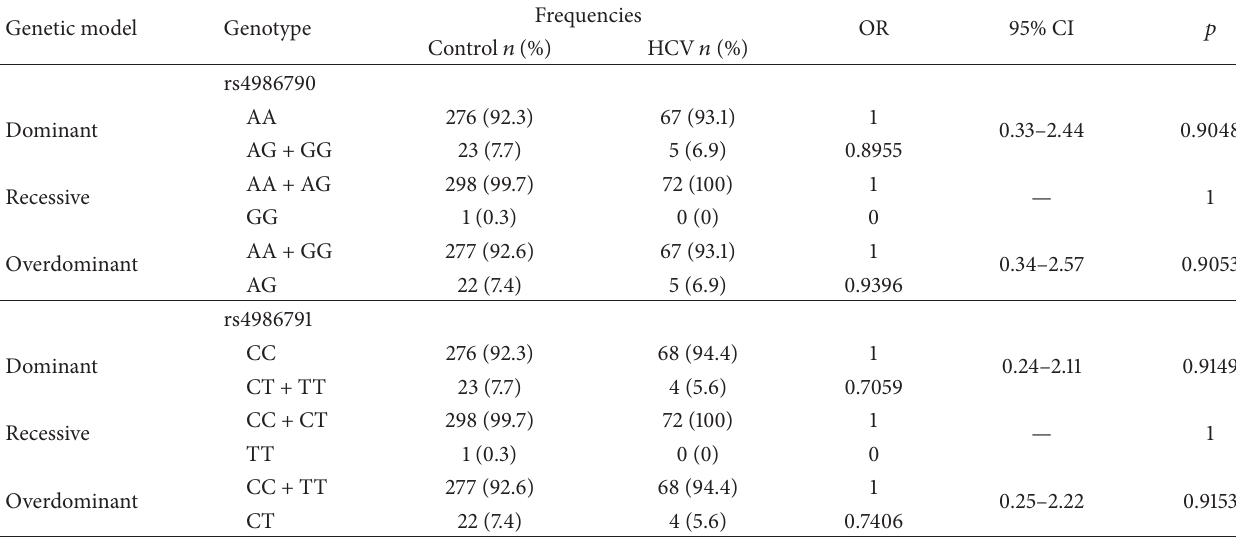
Table 5: Genetic models and risk of infection with